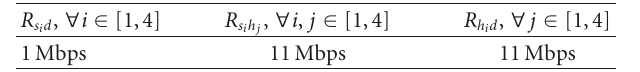
Table 7: Settings for study of network